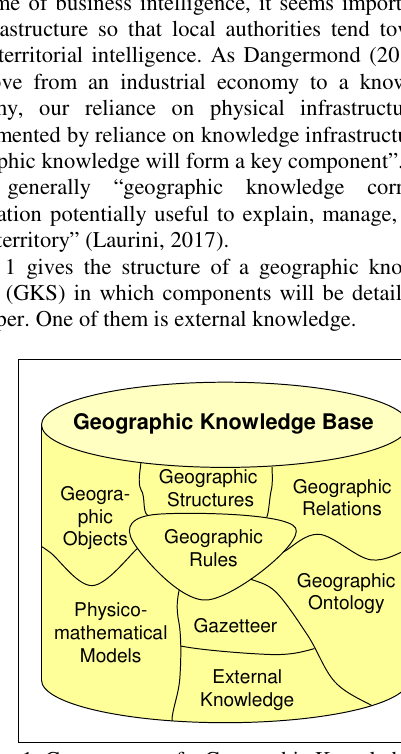
Figure 1. Components of a Geographic Knowledge System.